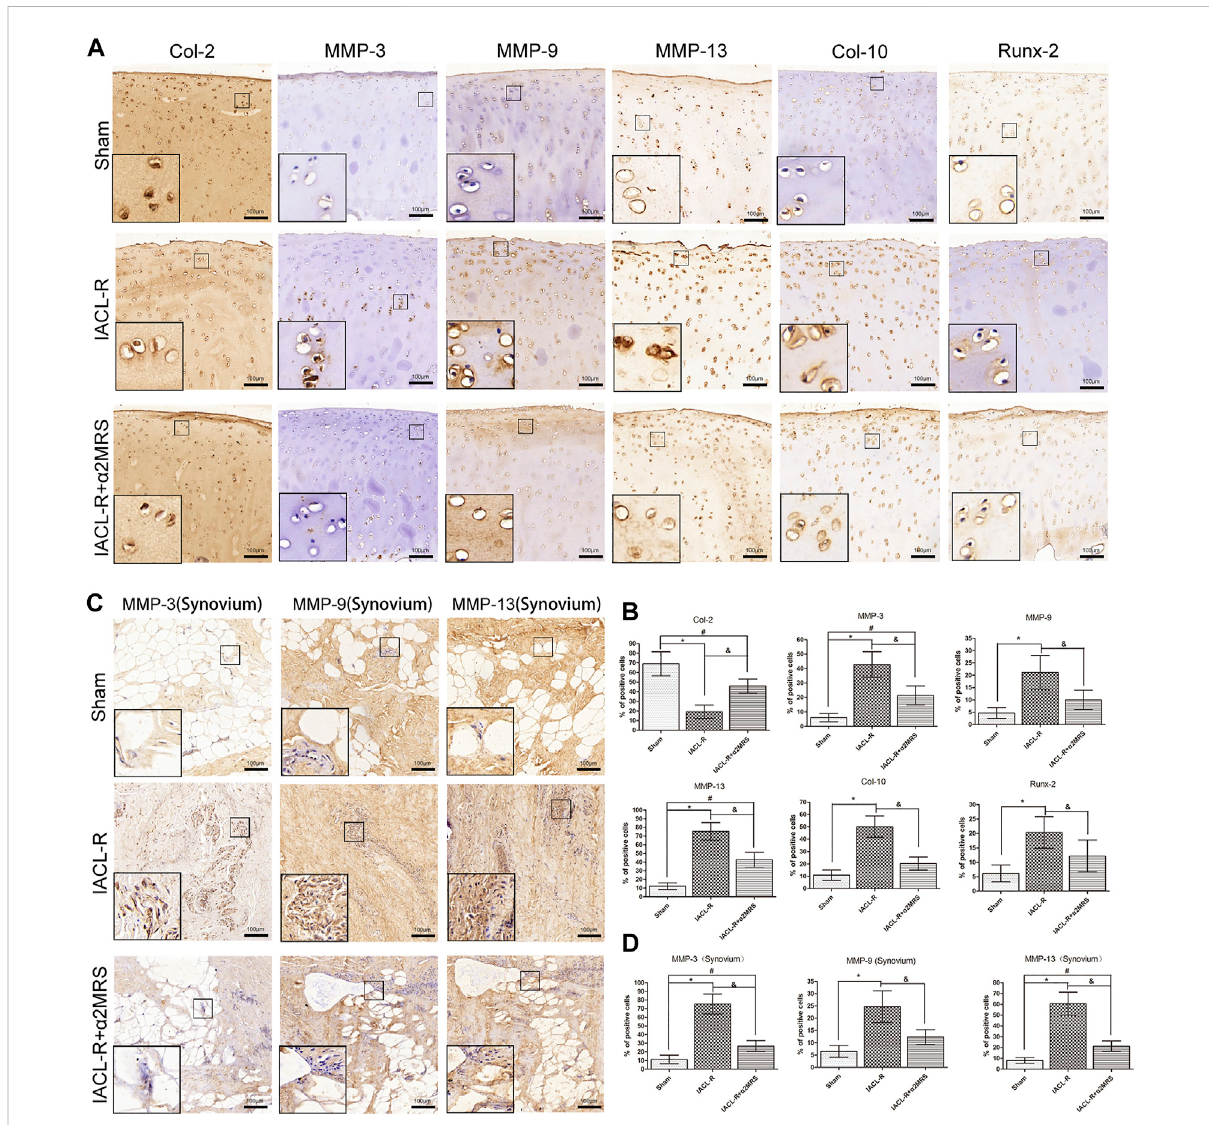
FIGURE 9 (A) :ArticularcartilageimmunostainingshowedthatMMP-3,MMP-9,MMP-13,Runx-2,andCol-10stainingsigni fi cantlyincreasedintheIACL-R mini pig group but were lower in the IACL-R+ α 2MRS group. In contrast, Col-2 expression in articular cartilage was higher in the IACL-R+ α 2MRS group than in the IACL-R group. (B) Quantitative immunohistochemical analysis of articular cartilage. (C) synovium immunostaining showed that MMP-3, MMP-9 and MMP-13 staining signi fi cantly increased in the IACL-R mini pig group but were lower in the IACL-R+ α 2MRS group. (D) Quantitative immunohistochemical analysis of synovium. * = p < 0.05, sham group versus IACL-R group; # = p < 0.05, sham group versus IACL- R+ α 2MRS group; and = p < 0.05, IACL-R group versus IACL-R+ α 2MRS group. The bars show the mean ± SD ( n =